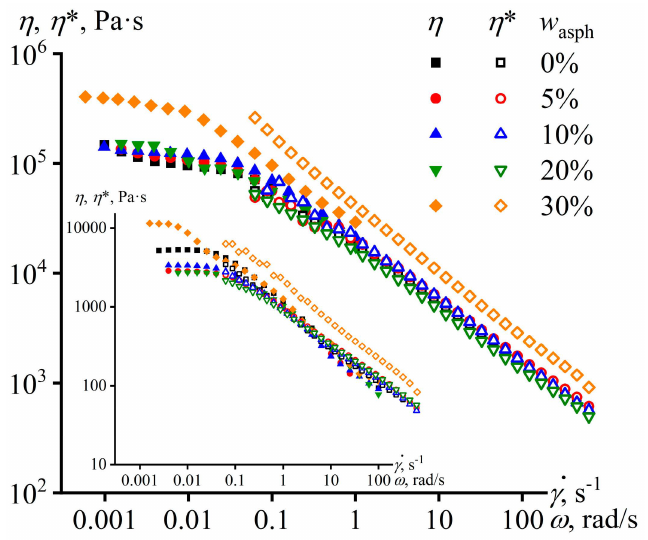
Figure 6. The dependences of steady-state viscosity and complex viscosity on, respectively, shear rate and angular frequency for PIB and its mixtures containing a different mass fraction of asphaltenes at 25 ◦ C (the mainline figure) and 120 ◦ C (the